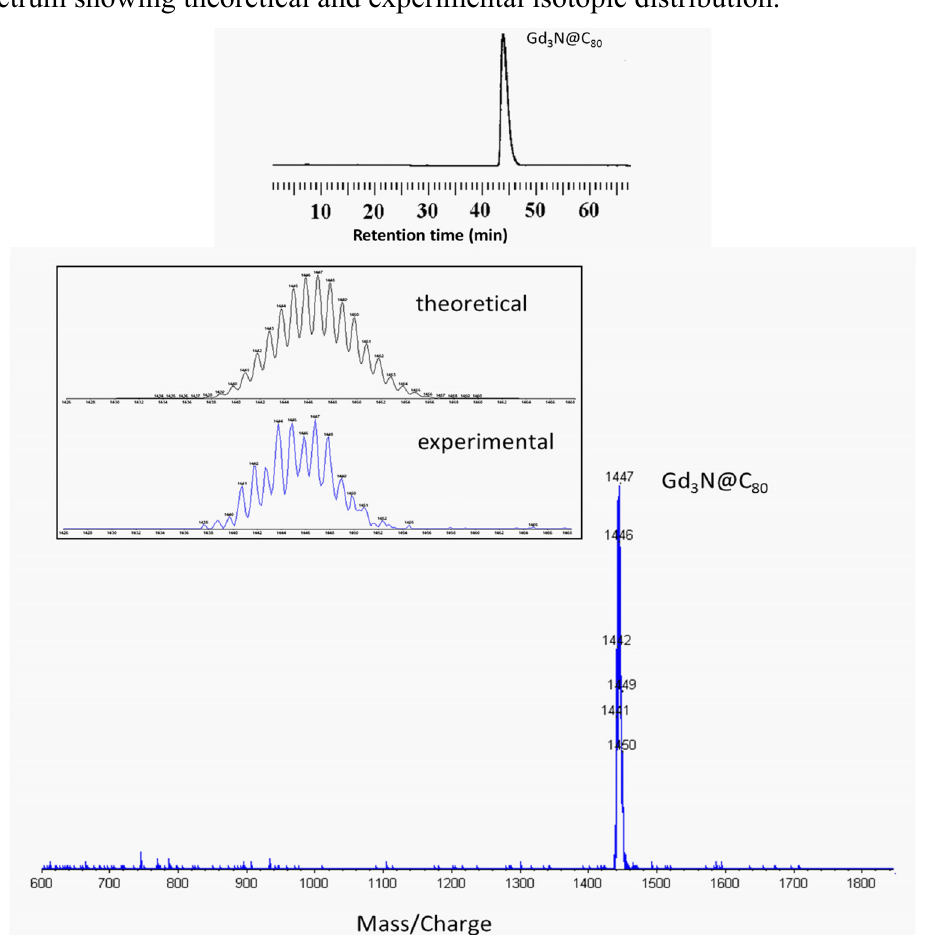
Figure 2. ( top ) HPLC trace of purified Gd time-of-flight (LD-TOF) mass spectrometry of the purified Gd the spectrum showing theoretical and experimental isotopic